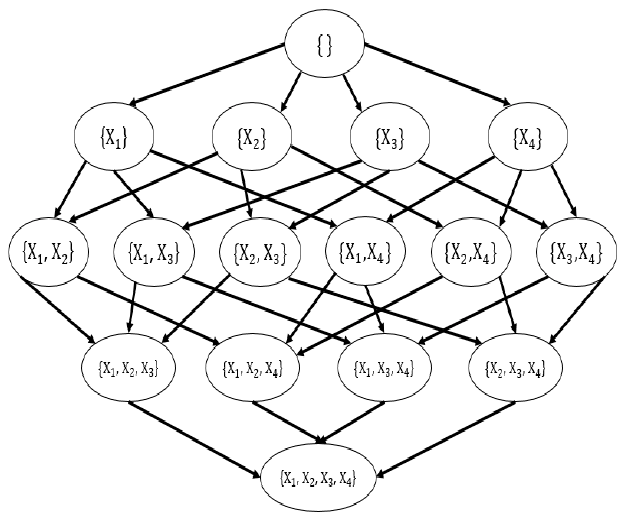
Figure 4. The order graph of four variables.